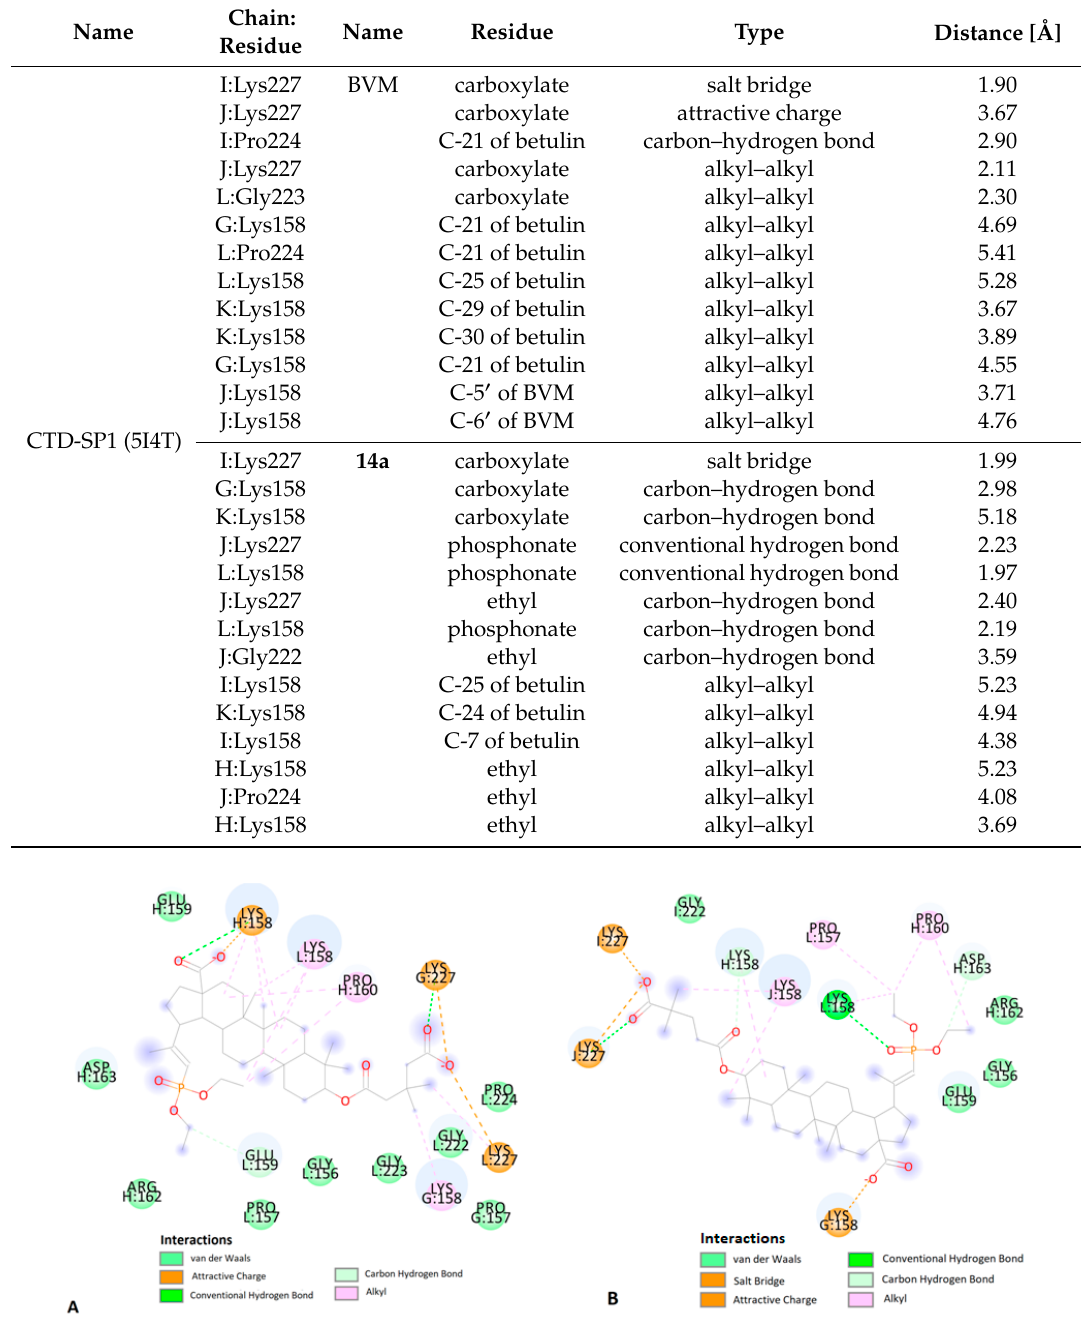
Figure 8. ( A ) Interactions between 13b and HIV-1 CA CTD-SP1 protein; ( B ) interactions between 13c and HIV-1 CA CTD-SP1 protein.